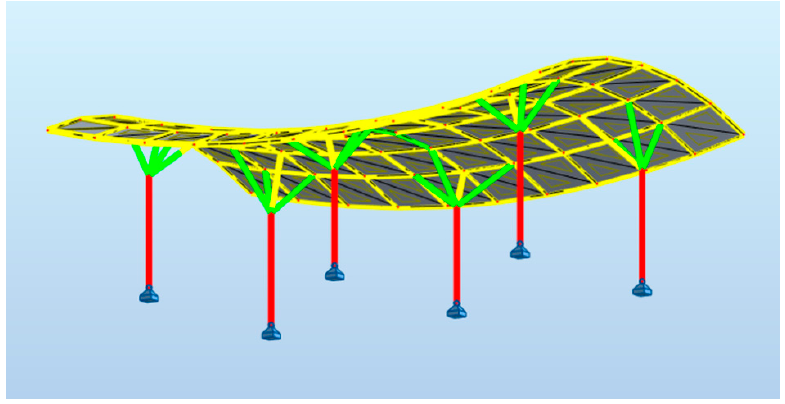
Figure 5. Maps on bars—distribution of axial force F X.